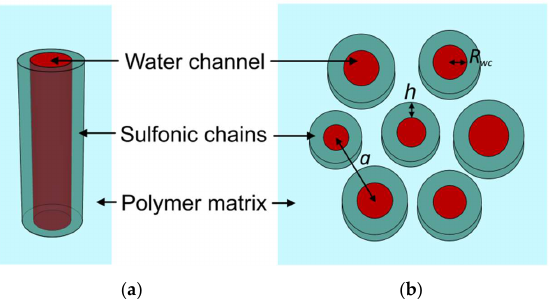
Figure 1. Model schematic of a separate cylindrical ionic domain ( a ) and hexagonal cluster ( b ).